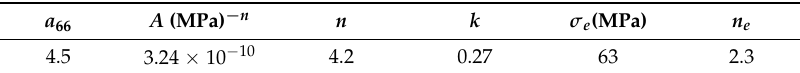
Table 1. Parameters in the model (Equation (15)) .